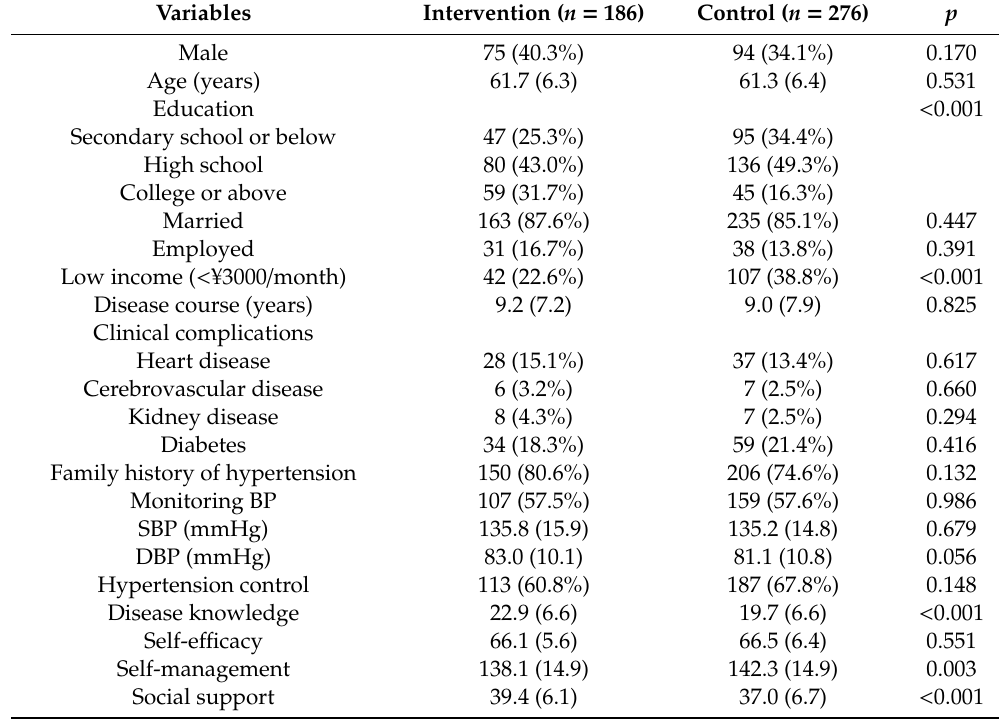
Table 1. Baseline characteristics of participants. BP: blood pressure; DBP: diastolic BP; SBP: systolic